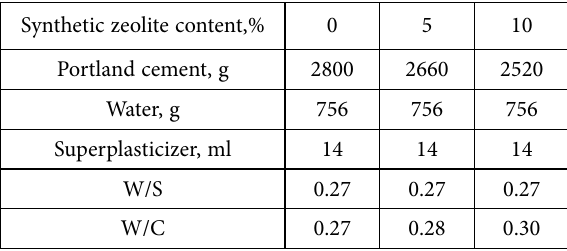
Table 1. Compositions of cement paste Synthetic zeolite content,% 0 5 10 Portland cement, g 2800 2660 2520 Water, g 756 756 756 Superplasticizer, ml 14